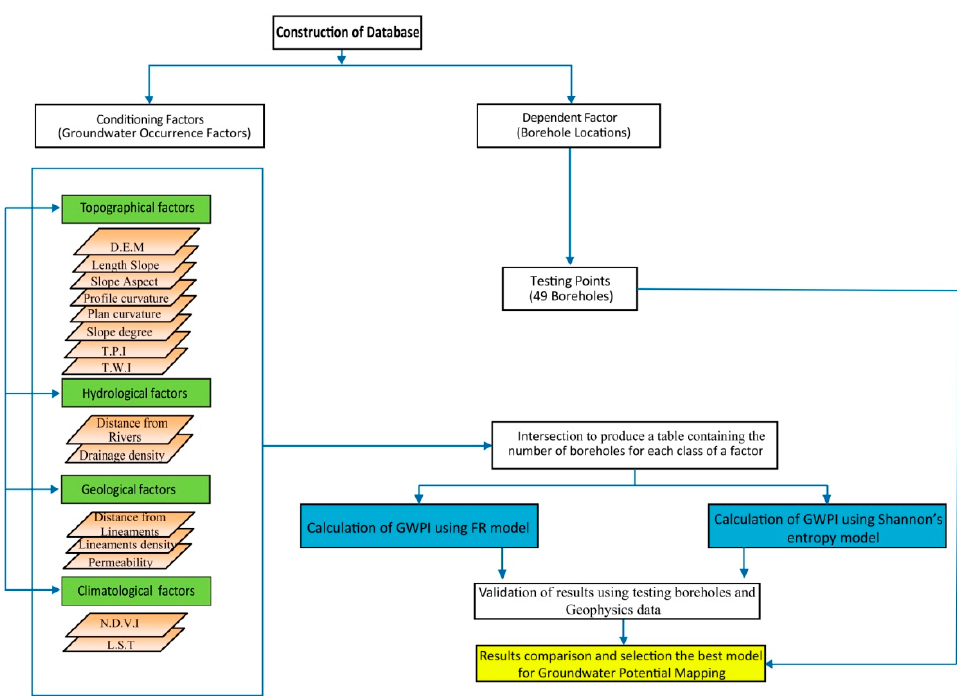
Figure 5. Flow chart of the methodology used in this study.